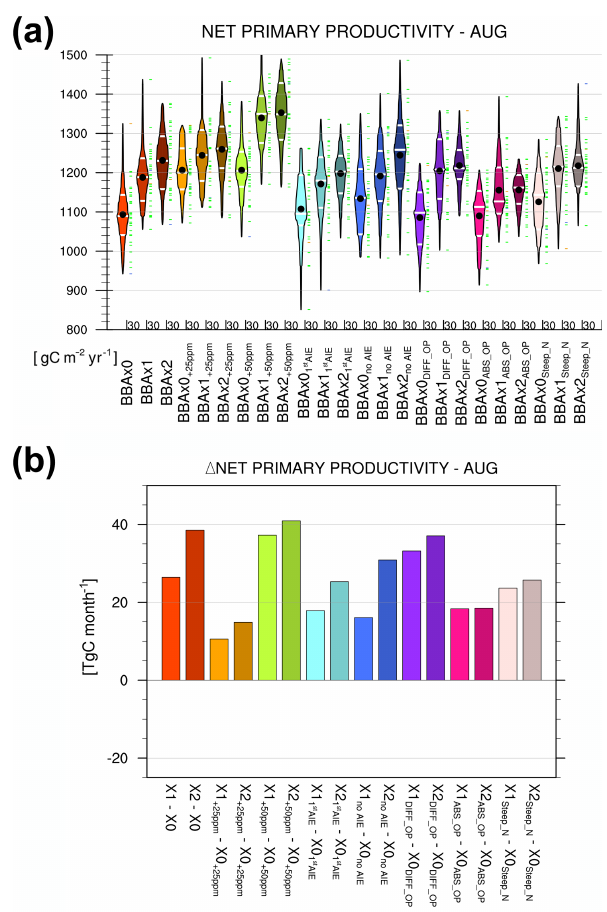
Figure 9. Shown in panel (a) is a box-and-whisker plot of the net primary productivity monthly means for August averaged over the central Amazon. Results are shown for the main experiment (see text, Sect. 2.2) and the four additional sensitivity experiments (see text, Sect. 2.3). Individual members of the 30-year run are repre- sented by the green dashes. Black dots correspond to the ensemble mean. Dashed white lines are the 25th, 50th and 75th percentiles. Shown in panel (b) are the changes in NPP in each sensitivity ex- periments, calculated relative to their respective baseline simulation (e.g. X1 + 25ppm – X0 + 25ppm is the differences between the BBAx1 and BBAx0 simulations with + 25ppm increase in CO 2 concentra-